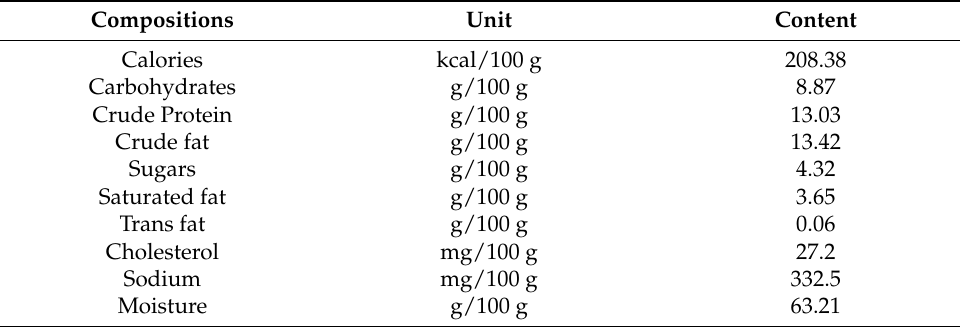
Table 7. Proximate composition of braised mackerel with radish.